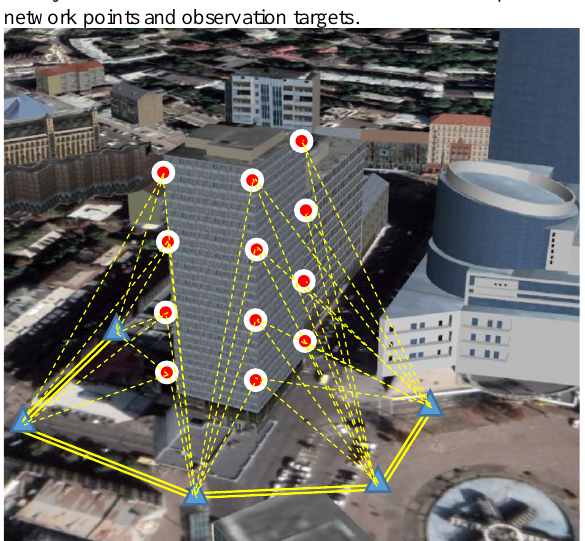
Figure 5 . Virtual model for monitoring design and observation scheme.